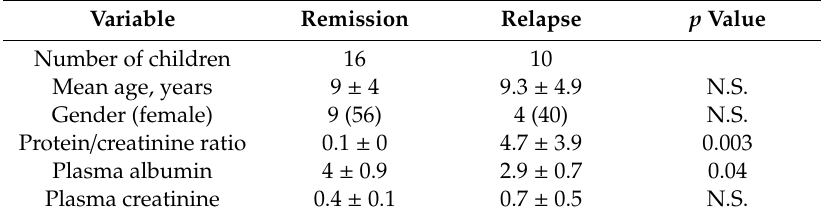
Table 3. Demographic and clinical characteristics of children with nephrotic syndrome according to participants with remission and